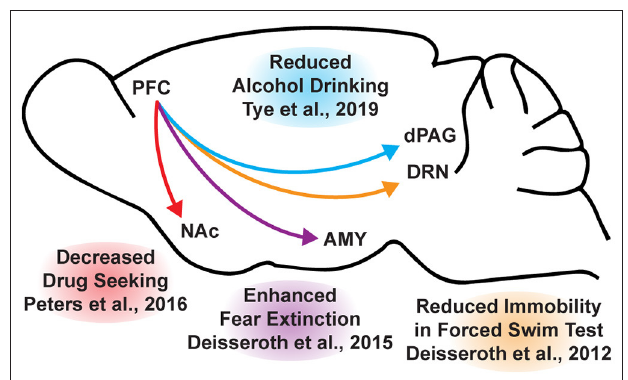
FIGURE 3 | Opto- and chemogenetic experiments have revealed a number of circuits originating in the PFC that are relevant to the treatment of neuropsychiatric disorders. Arrows indicated excitatory